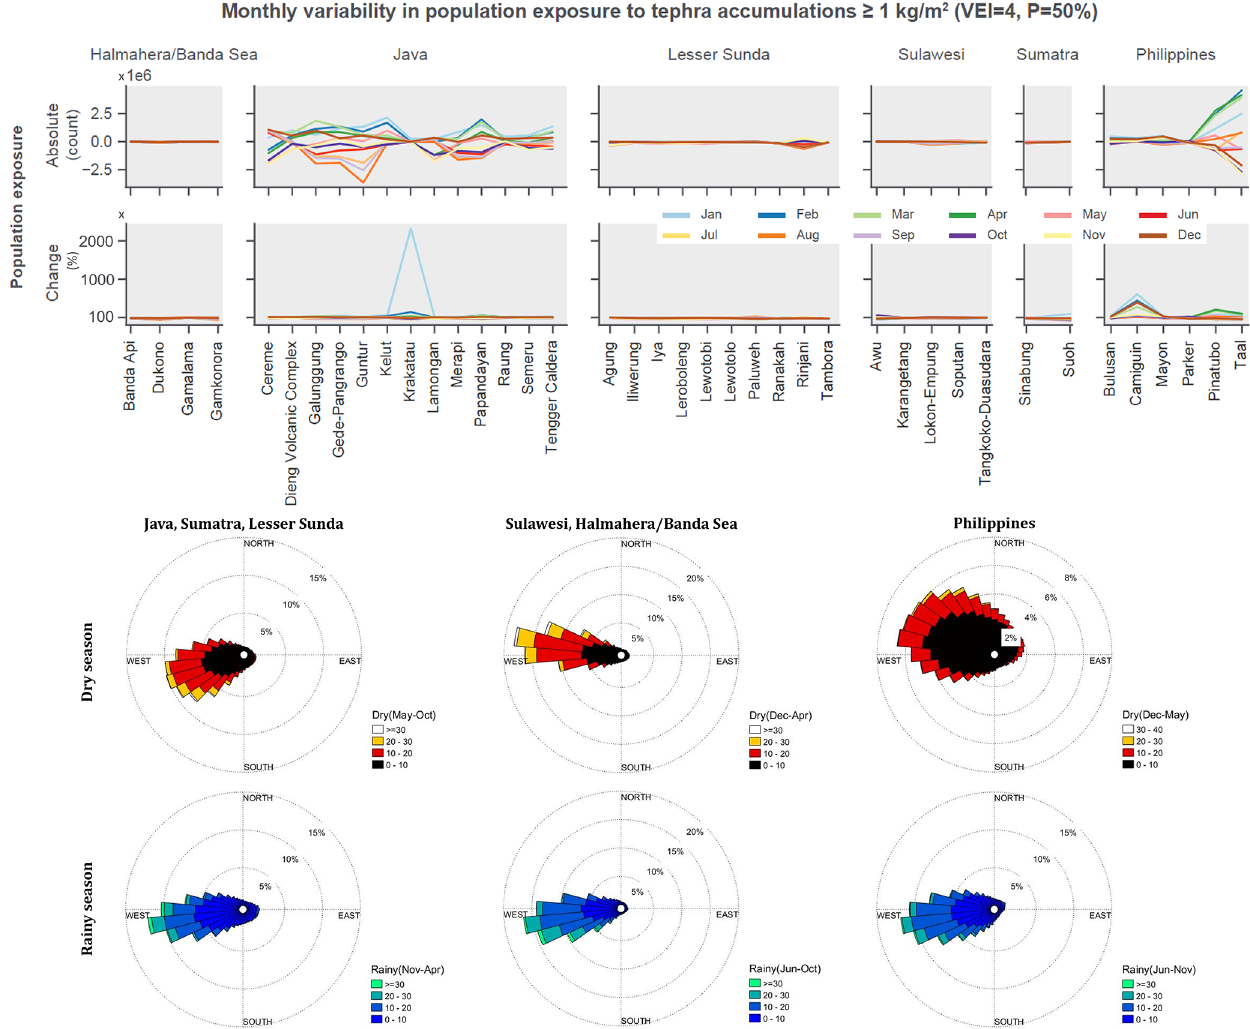
Figure 10. Seasonality patterns in population exposure values (top row) and percent changes in population exposure (second row) from the 50% probability of ≥ 1kgm − 2 tephra fallout associated with a VEI 4 eruption. Values represent the difference in exposure value between the tephra hazard estimated from all 2880 hourly synoptic wind profiles across the whole 12 months of a year (normalised to the 0, or 100%, line) and a subset of this total population of wind profiles extracted per month, in which each line represents a different month. A value lower than zero or 100% represents a decreased exposure in that month and a value greater than zero or 100% the opposite. Averaged wind conditions for the dry and rainy seasons for the three main climatic regions are shown in the next rows for altitudes of 5 to 15kma.s.l. (above sea